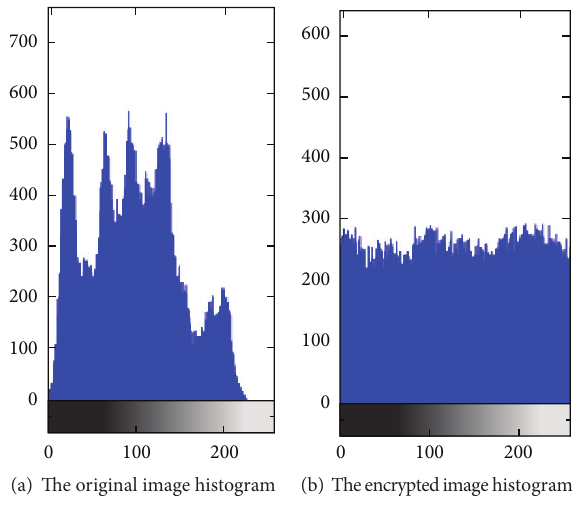
Figure 13: The histogram comparison of G component.